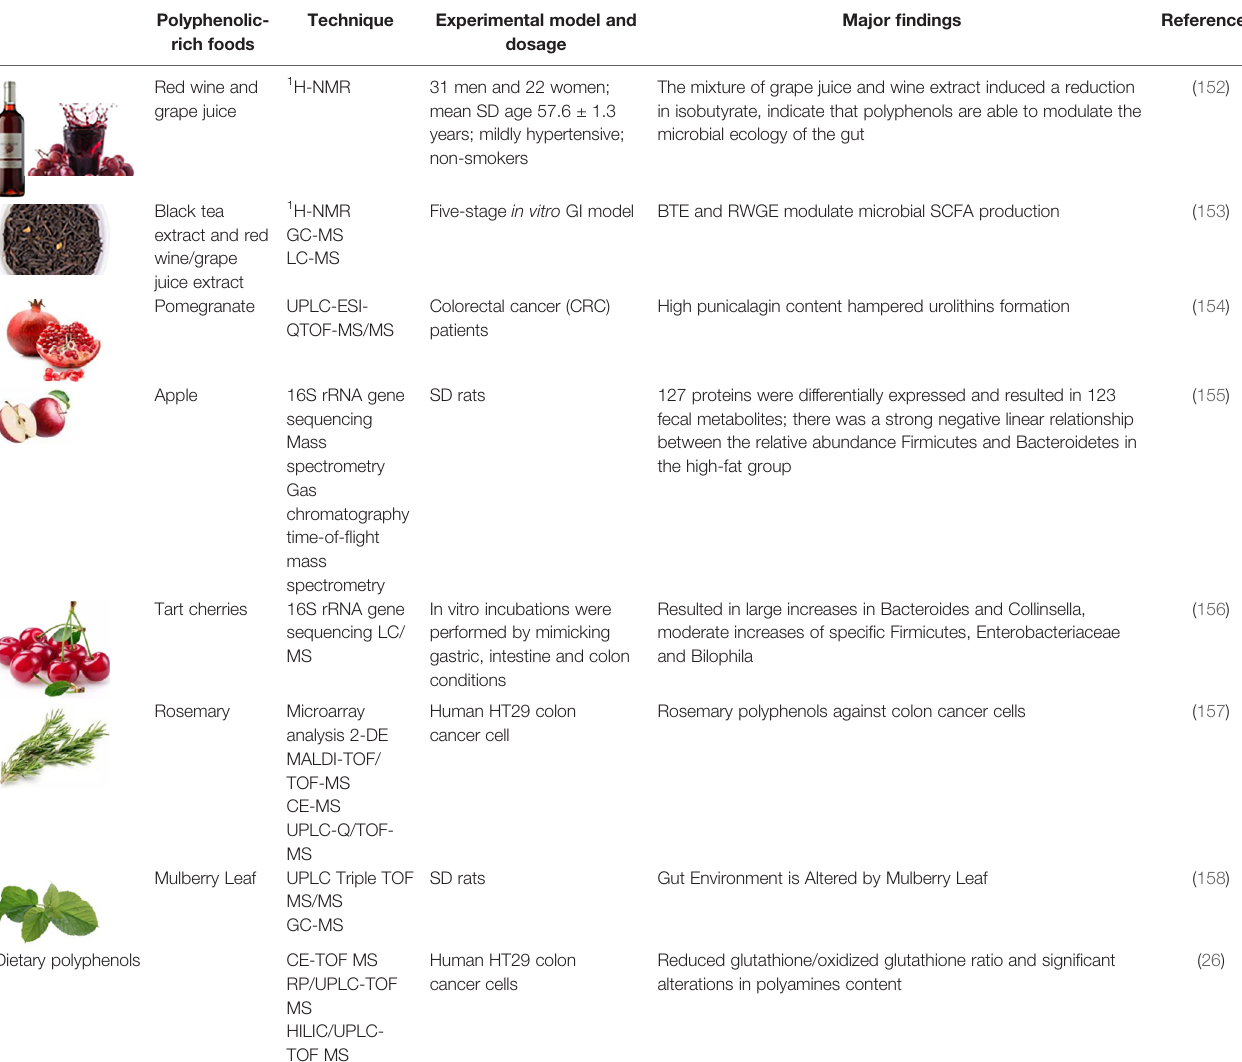
TABLE 2-3 | Metabolomics and multi-omics in understanding the GI protective effects by polyphenols and polyphenolic-rich foods. Polyphenolic- rich